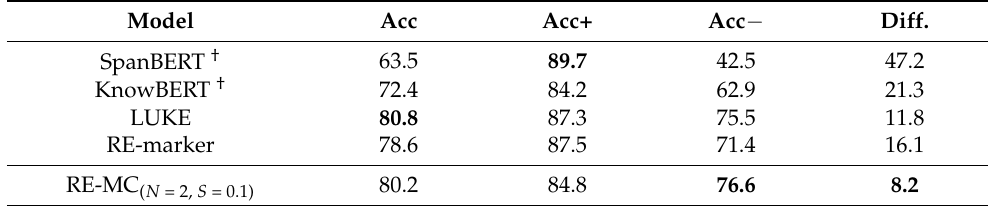
Table 5. The test scores on CRE. A model with a higher Acc − score, and a smaller gap (Diff.) between Acc+ and Acc − is considered more robust to heuristic methods, i.e., spurious association. Results with † are from